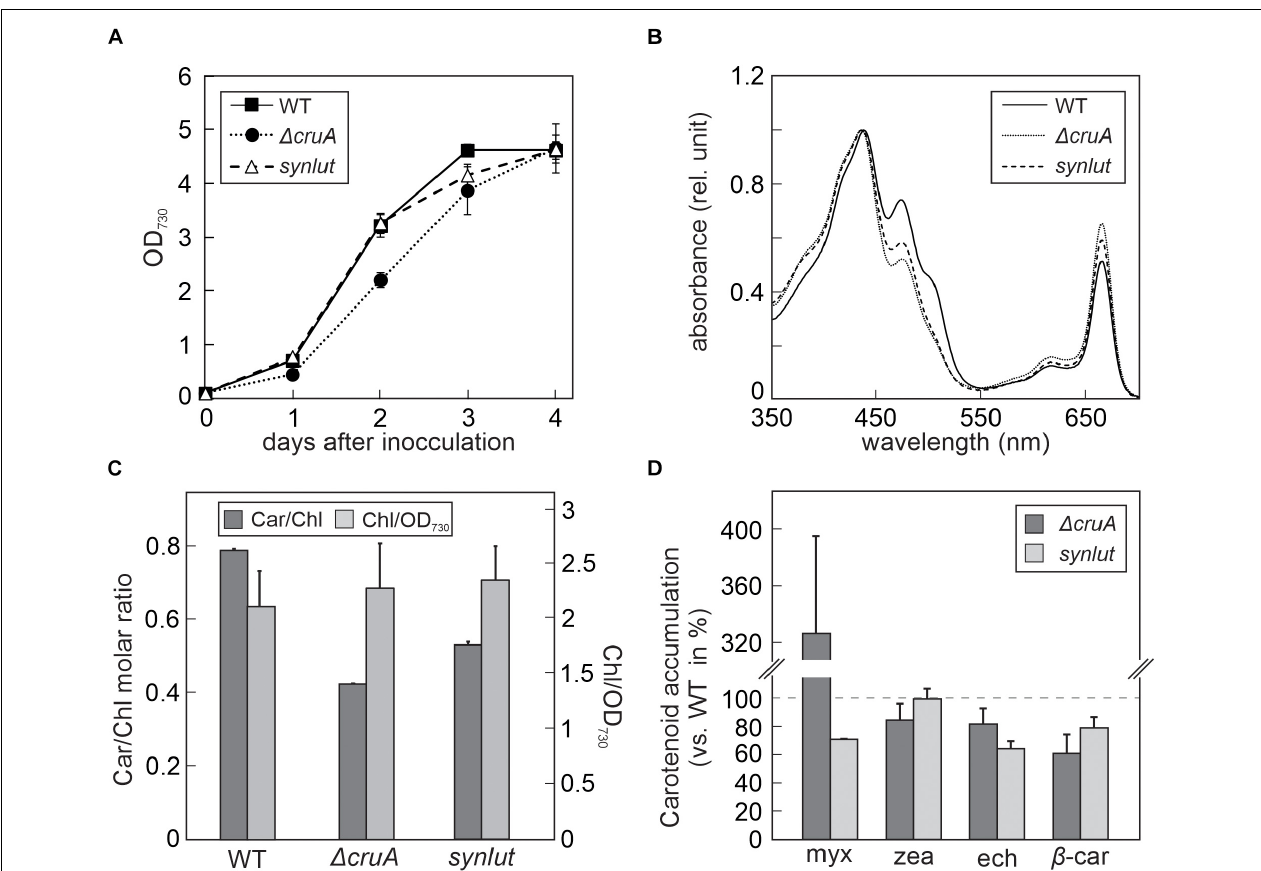
FIGURE 4 | Growth rates and pigment composition of (cid:49) cruA and synlut . (A) Growth curves of (cid:49) cruA and synlut in comparison to Synechocystis wild-type (WT) cells. Cultures were grown mixotrophically in blue-green-11 (BG-11) medium containing 5 mM glucose at 23 ◦ C under continuous illumination at 30 µ mol photons m - 2 s - 1 . The optical density (OD) of Synechocystis cultures was photometrically determined daily at a wavelength of 730 nm. Means and standard deviations of three biological replicates are shown. (B) Total absorption spectra of pigment samples from WT, (cid:49) cruA and synlut cells. Spectra were normalized to the maximal absorption value. (C) Molar ratios of total carotenoids to chlorophyll a (Car/Chl) and chlorophyll a content (normalized to the amount in 1 mL of cells at OD 730 nm = 1) in WT, (cid:49) cruA and synlut . Values represent averages of three biological replicates and two independent experiments. Error bars indicate standard deviations. (D) Levels of major carotenoids in (cid:49) cruA and synlut relative to WT. Means of three replicates are shown, and error bars represent standard deviations. Abbreviations: myx: myxoxanthophyll, zea: zeaxanthin, ech: echinenone, and β - car: β -carotene.